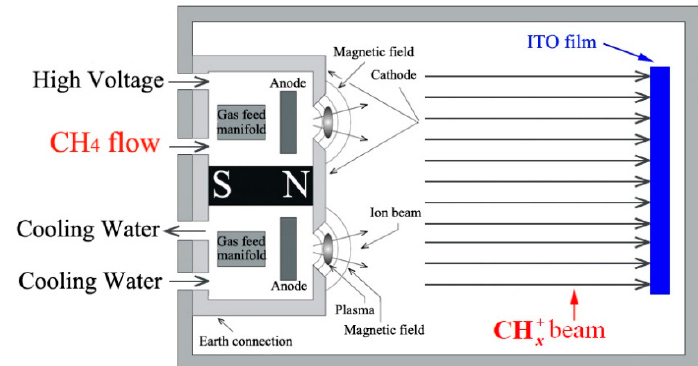
 beam bombardment x